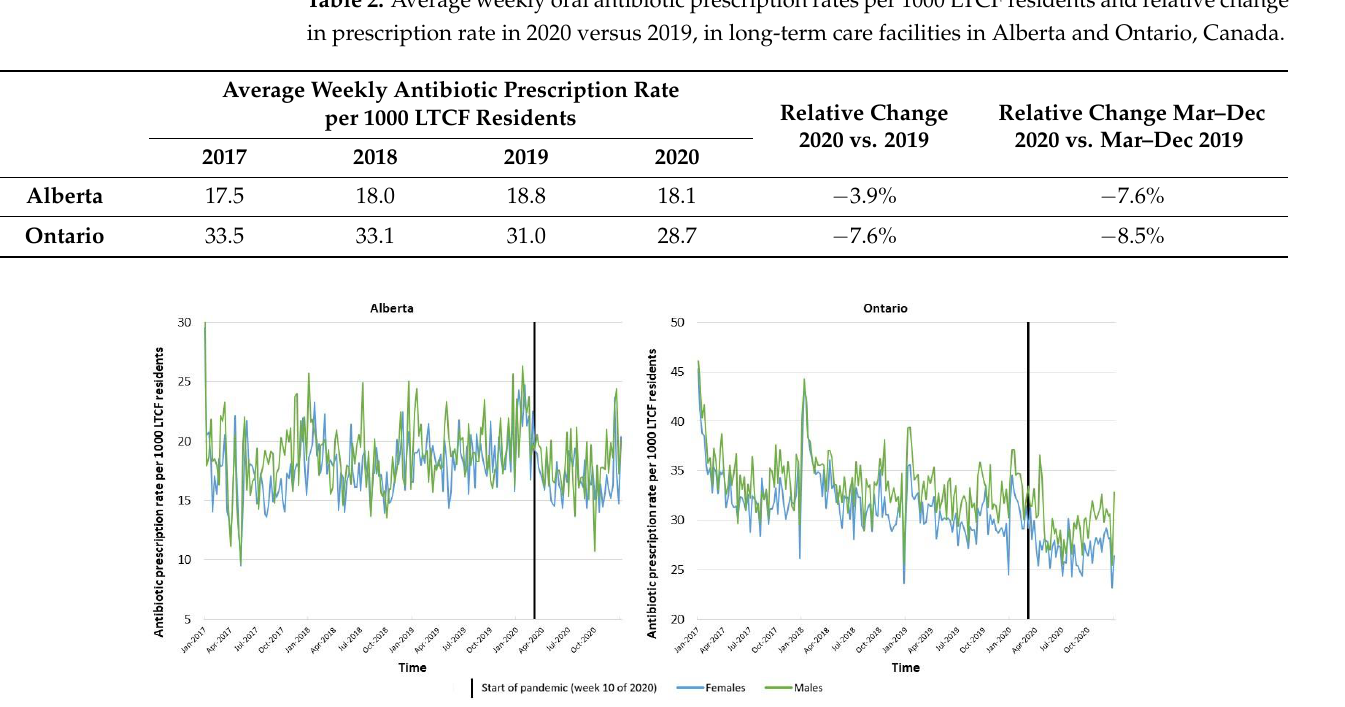
Figure 2. Oral antibiotic prescription rates per 1000 LTCF residents, Canada, 2017 – 2020, stratified by sex.N.B. Low rates at the end of a calendar year and high rates at the beginning of a calendar year represent administrative artifacts.